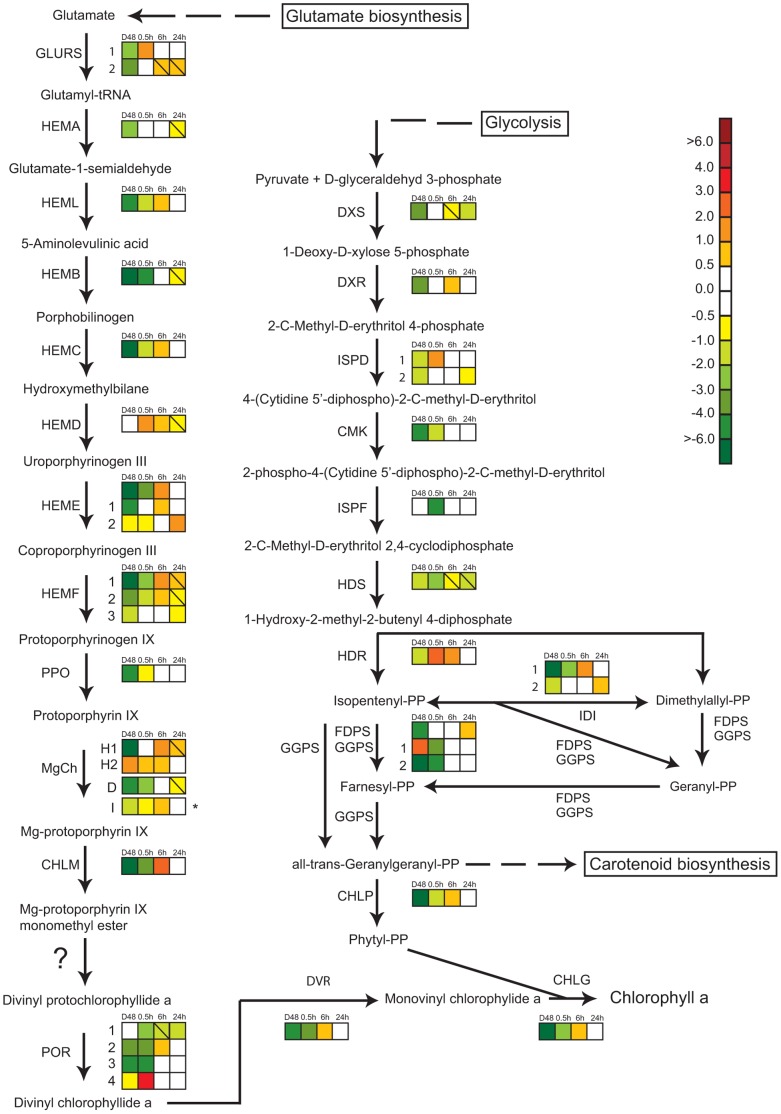
Gene expression responses in the hypothesized chlorophyll a and non-mevalonate pathways in P. tricornutum.Colored squares indicate the regulation pattern of genes encoding putative enzymes functioning in the two pathways after dark treatment for 48 h (D48) and re-exposure to white light (WL) for 0.5, 6 and 24 h. Continous white light (CWL) were control conditions. Squares with a diagonal line inside indicate genes with an expression ratio greater than +/−0.5 that are not significantly regulated. The asterisk marking the expression pattern of subunit I of Mg-chelatase (MgCh) indicates that the gene is chloroplast encoded, and that the expression ratios was assessed by qRT-PCR instead of microarray analysis. The scale on the right represents gene expression ratio values, log2 transformed. The gene encoding Mg-protoporphyrin IX monomethyl ester cyclase responsible for converting Mg-protoporphyrin IX monomethyl ester to divinyl protochlorophyllide a in higher plants [108] is absent in P. tricornutum, and this step is marked with a question mark in the figure. The abbreviations used are: GLURS: glutamyl-tRNA synthetase; HEMA: glutamyl-tRNA reductase; HEML: glutamate-1-semialdehyde 2,1-aminomutase, HEMB: porphobilinogen synthase; HEMC: hydroxymethylbilane synthase; HEMD: uroporphyrinogen-III synthase; HEME: uroporphyrinogen decarboxylase; HEMF: coproporphyrinogen III oxidase; PPO: protoporphyrinogen oxidase; MgCh: magnesium chelatase (comprising of subunits H, D and I); CHLM: Mg-protoporphyrin IX methyl transferase; POR: protochlorophyllide oxidoreductase; DVR: divinyl protochlorophyllide a 8-vinyl reductase; CHLG: chlorophyll synthase; DXS: deoxyxylulose-5-phosphate synthase; DXR: 1-deoxy-D-xylulose 5-phosphate reductoisomerase; ISPD: 2-C-methyl-D-erythritol 4-phosphate cytidylyltransferase; CMK: 4-diphosphocytidyl-2-C-methyl-D-erythritol kinase; ISPF: 2-C-methyl-D-erythritol 2,4-cyclodiphosphate synthase; HDS: 1-hydroxy-2-methyl-2-(E)-butenyl 4-diphosphate synthase; HDR: 4-hydroxy-3-methylbut-2-enyl diphosphate reductase; FDPS: farnesyl diphosphate synthase; GGPS: geranylgeranyl pyrophosphate synthase; IDI: isopentenyl pyrophosphate:dimethylallyl pyrophosphate isomerise; CHLP: geranylgeranyl reductase.